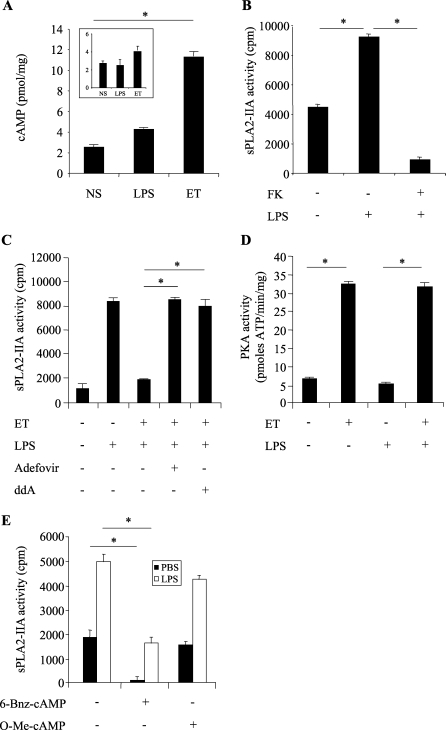
ET Impairs sPLA2-IIA Expression via a cAMP/PKA-Dependent-Pathway(A) AMs were treated with ET (1 μg/ml) and were then stimulated by LPS (50 ng/ml). After 30-min or 24-h (insert) incubation, cell lysates were collected and cAMP concentrations were measured by enzyme immunoassay (EIA) and expressed in picomoles per milligram of protein. NS, not stimulated.(B) AMs were treated with forskolin (FK; 20 μM) followed by LPS incubation.(C) Reversal of ET-mediated inhibition of sPLA2-IIA secretion by ET inhibitors. AMs were treated with adefovir (10 μM) for 5 h and incubated with ET (1 μg /ml) for 1 h. In a separate assay, ET (1 μg/ml) was treated with 100 μM ddA for 1 h and incubated with AMs for an additional 1 h. AMs were then stimulated with LPS (50 ng/ml) overnight, and supernatants were collected to measure sPLA2-IIA secretion.(D) After 2-h incubation, cell lysates were collected, and PKA activity was measured.(E) AMs were treated with 6-Bnz-cAMP or O-Me-cAMP (200 μM) for 1 h before overnight LPS stimulation.The data are the mean ± SEM and are representative of three separate experiments. An asterisk (*) indicates p <0.05.